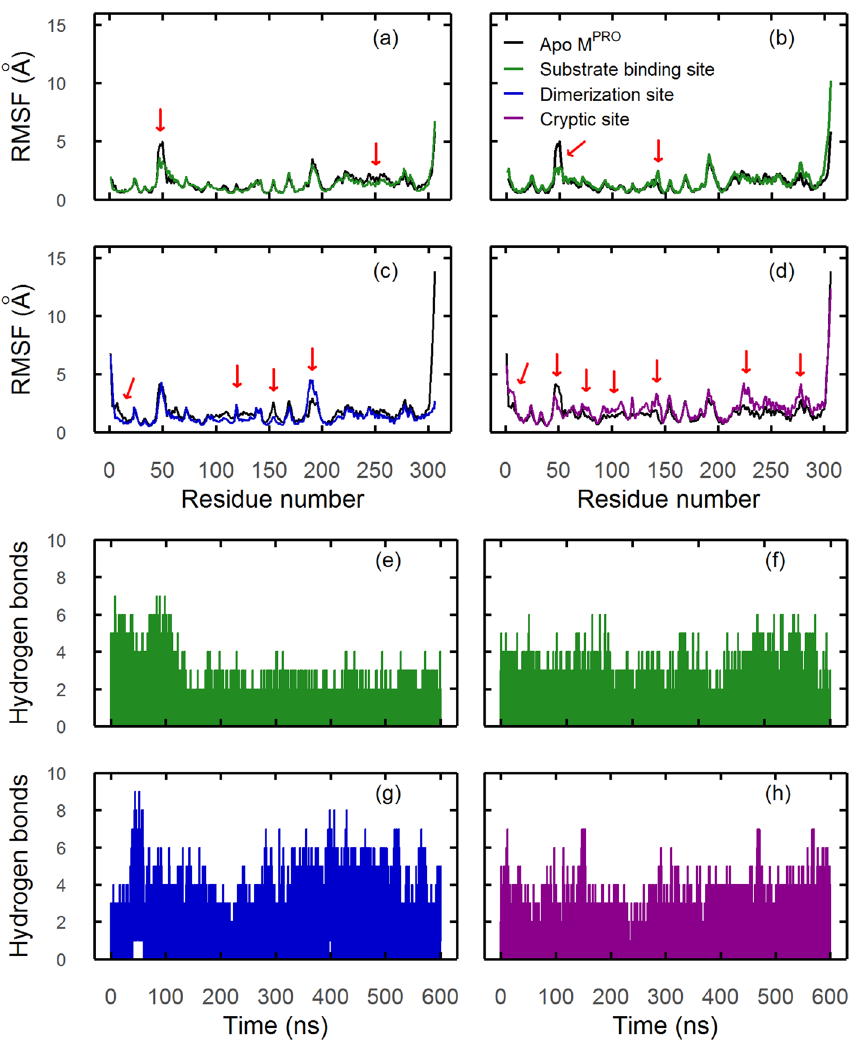
Figure 6. RMSF and hydrogen bond plots of flavonoid-SARS-CoV-2 M PRO selected ligands. In both plot types, ligands are shown according to previous colour code: green for substrate, blue for dimeric and magenta for cryptic sites. ( a–d ) Protein RMSF plots. RMSF of apo- dimeric or monomeric (protomer A) protein is shown in black. Red arrows show the most significant differences between apo- and holo- structures. ( e–g ) Total number of hydrogen bonds formed between SARS-CoV-2 M PRO and flavonoid ligands. ( a/e ) Dorsilurin E restrained the flexibility of residue 49. This ligand also had a long-range effect by reducing the flexibility of domain III residues 200–275. Dorsilurin E held the lowest average number of hydrogen bonds, 0.8 (s = 0.99). ( b/f ) Euchrenone a11 restrained the flexibility of residue 49. Additionally, euchrenone a11 increased fluctuation in domain II (S1’ subpocket) residues 143–146. This ligand also held the second lowest average number of hydrogen bonds, 0.9 (s = 0.94). ( c/g ) Sanggenol O restrained the protein movement except for residues 186–198, which showed flexibilization. Sanggenol O shows remarkable fluctuations in its hydrogen bonds, holding an average of 1.6 hydrogen bonds through time (s = 1.30). ( d/h ) CHEMBL2171598 increased the protein flexibility throughout its sequence, with a marked increase in domain II (residues 100–182) and residues 210–307 of domain